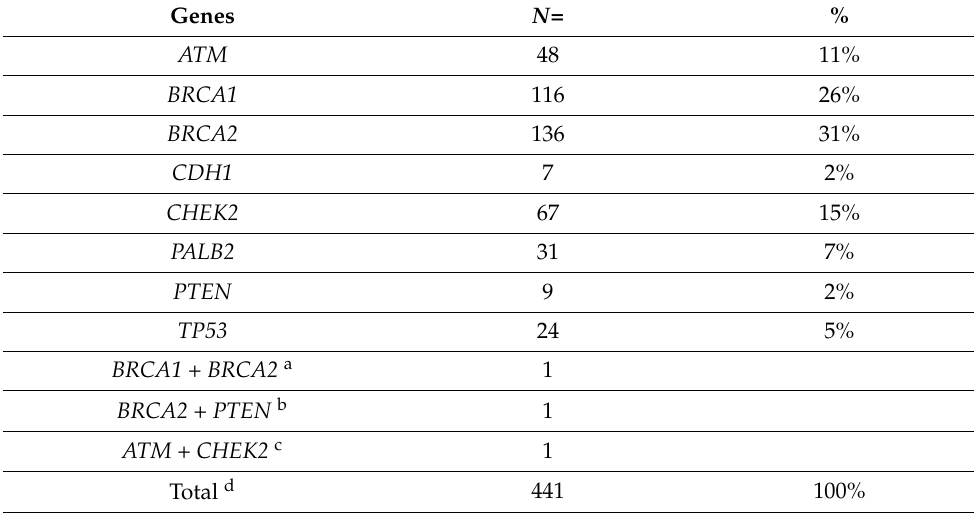
Table 1. Women carrying PVs in breast cancer risk genes. Genes